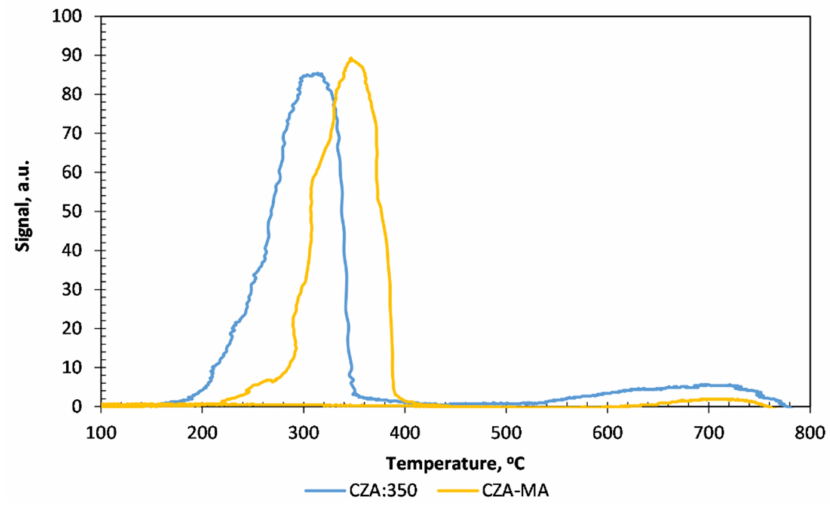
Figure 2. TPR analysis results of CZA:350 and